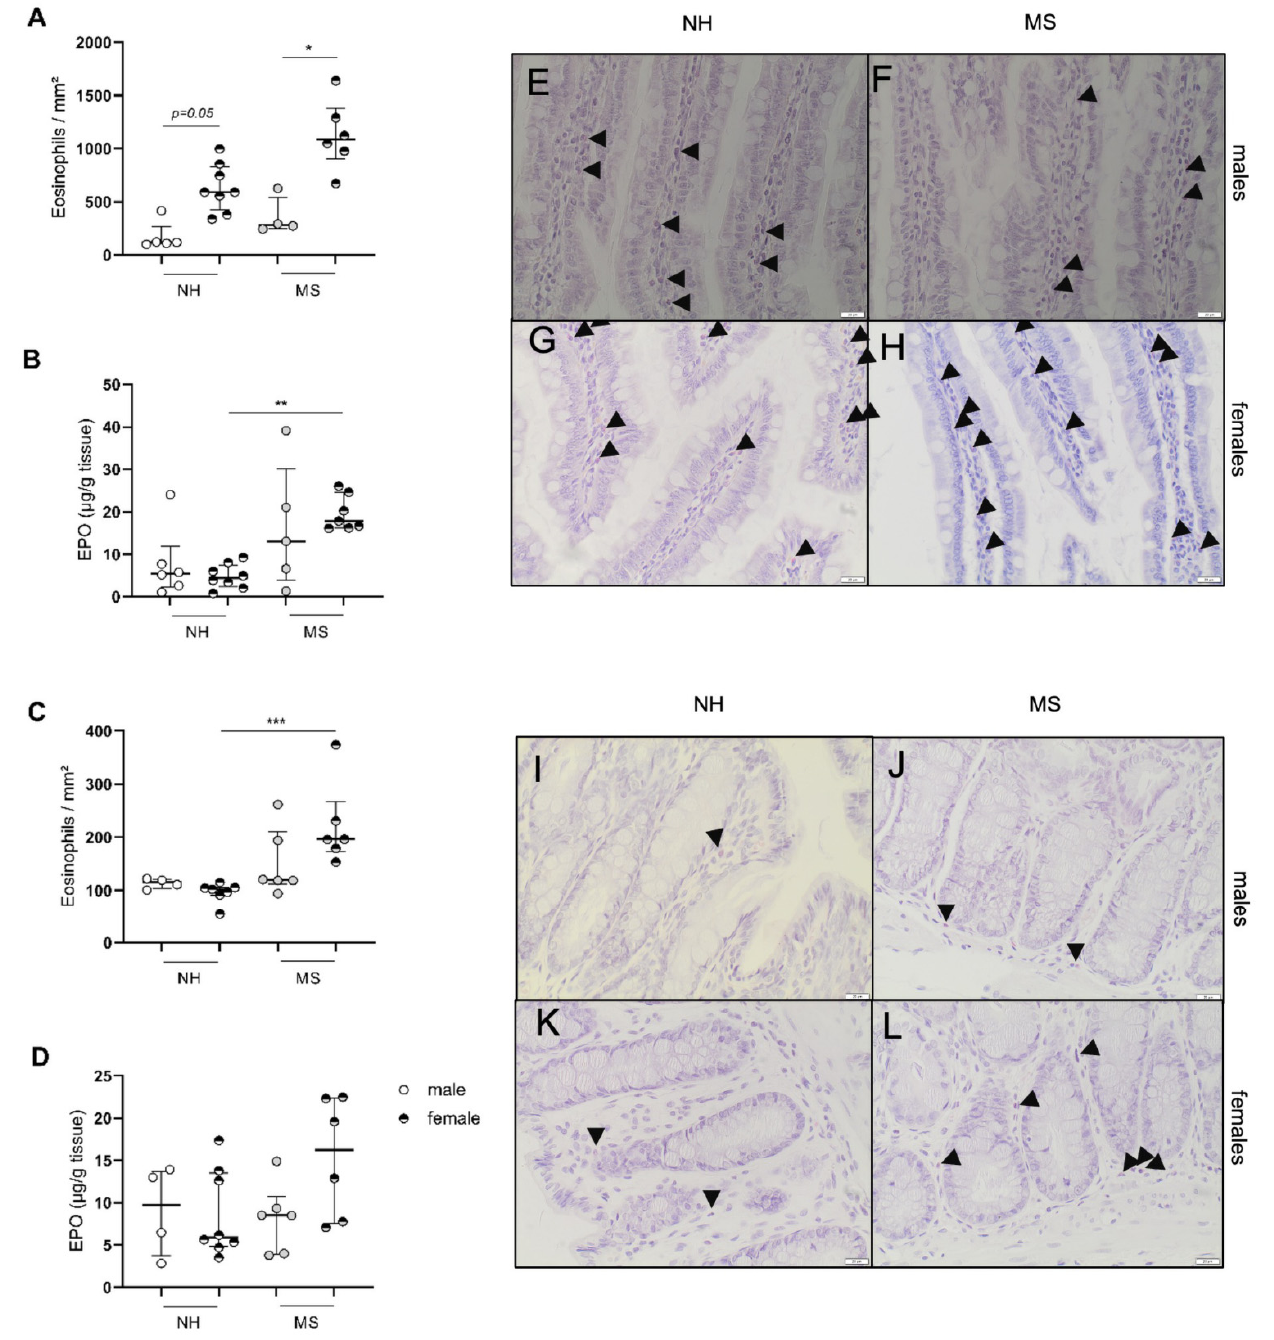
Figure 2. Eosinophil infiltration and activation in the jejunum and colon after maternal separation. Eosinophils stained by chromotrope 2R in the jejunum ( A ) and the colon ( C ) of BBDPN males and females. Activation of eosinophils assessed by enzymatic assay quantifying the eosinophil peroxidase in the jejunum ( B ) and colonic mucosa ( D ). Representative pictures of the jejunum for male NH ( E ); female NH ( F ); male MS ( G ); female MS ( H ) and for the colon for male NH ( I ); female NH ( J ); male MS ( K ); female MS ( L ). Eosinophils are indicated by arrows. Data are presented as median ± IQR. * p < 0.05; ** p < 0.01; *** p < 0.001. NH—nonhandled; MS—maternal separation. n = 4–8 per group.